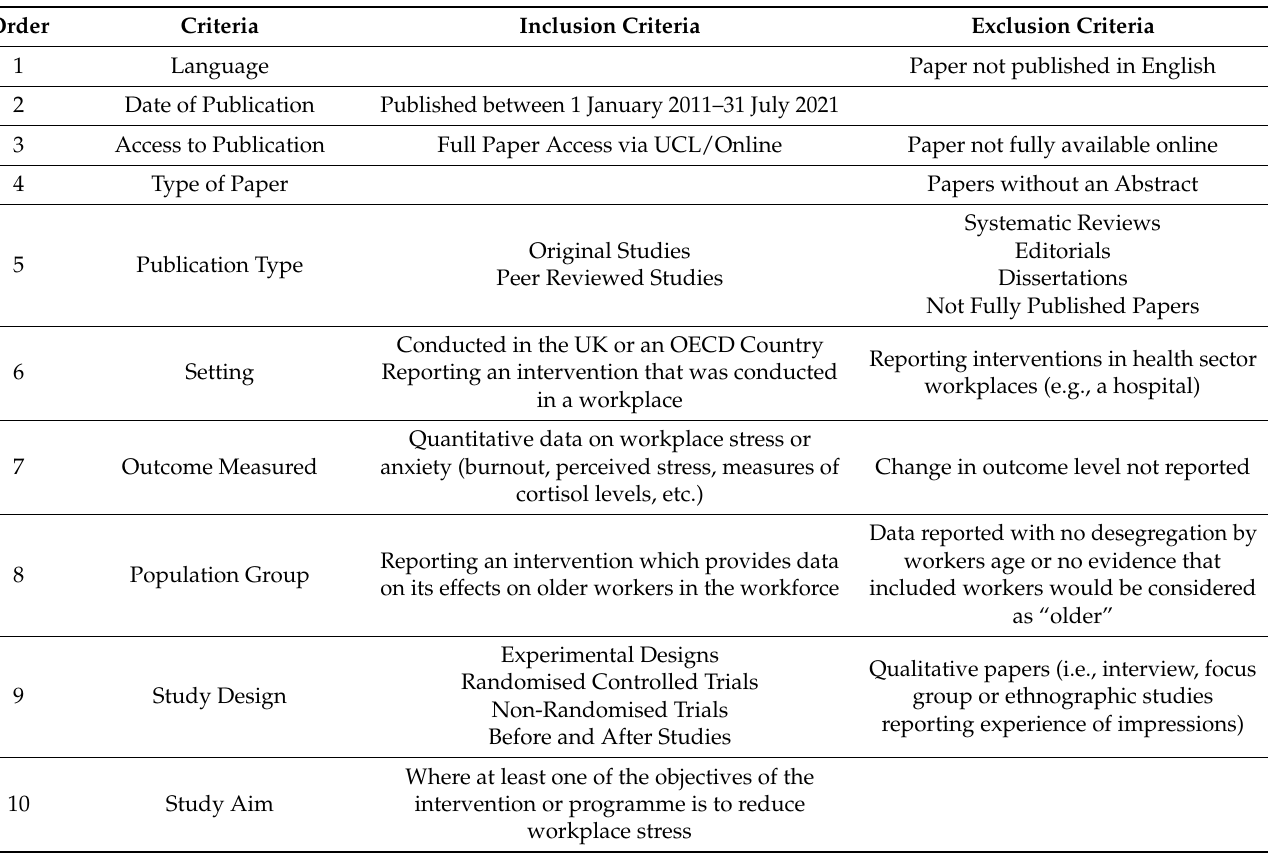
Table 3. Inclusion/Exclusion